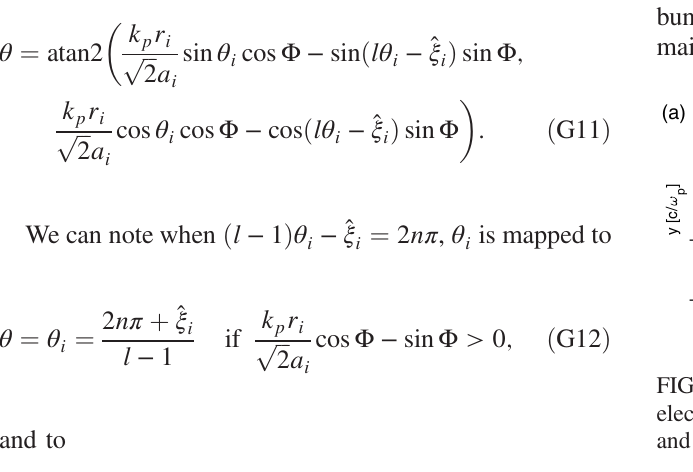
¼ 0 . 1 ; a ¼ 0 . 1 ; k ξ ¼ 2 . 24 r p i i p i